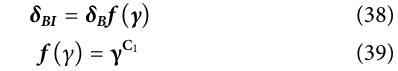
FIGURE 4 | Variation of DF with an equivalent spherical diameter of stable bubble.